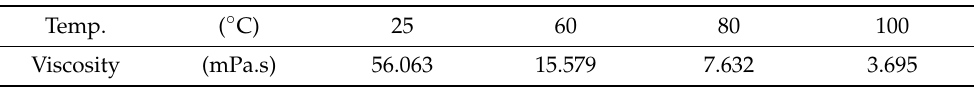
Table 4. Viscosity values for the different temperatures used for the tests lubricated with PAO 8.